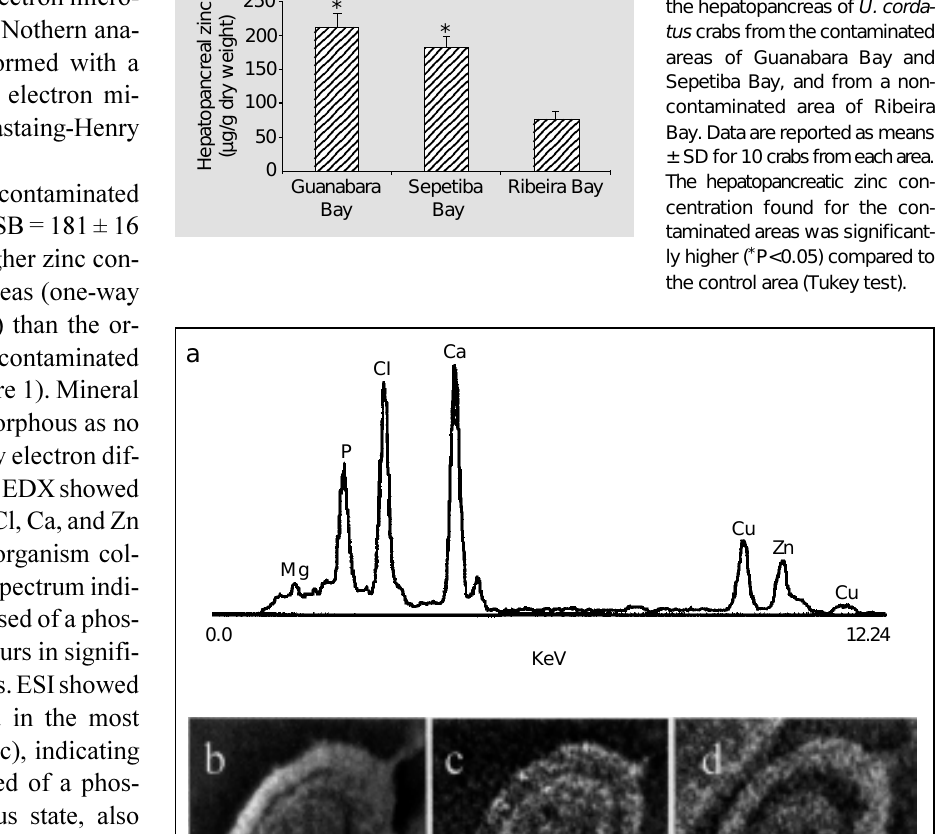
Figure 2 - a , X-Ray microanalysis spectrum of a typical hepatopancreatic granule isolated from a crab collected in the contaminated area of Guanabara Bay. Note the presence of magnesium, phosphorus and calcium, typical of phosphate intracellular granules, and zinc. Chlorine is also present, but it could be from NaOCl used for digestion. Oxygen is not detectable in the spectrum because of the beryllium window of the detector. Copper peaks come from the electron microscope grid. b , Electron spectroscopic image (ESI) of oxygen in a granule from a contaminated region. White rings correspond to higher contents of the element inside the structure. Section thickness, @ 40 nm. c , ESI of phosphorus in the same granule showing that phosphorus and oxygen (see previous figure) are colocalized inside the structure. d , ESI of calcium inside the same granule as in the previous two figures. The arrow shows a region where the calcium content is very low as compared to oxygen and phosphorus. Bar = 0.5